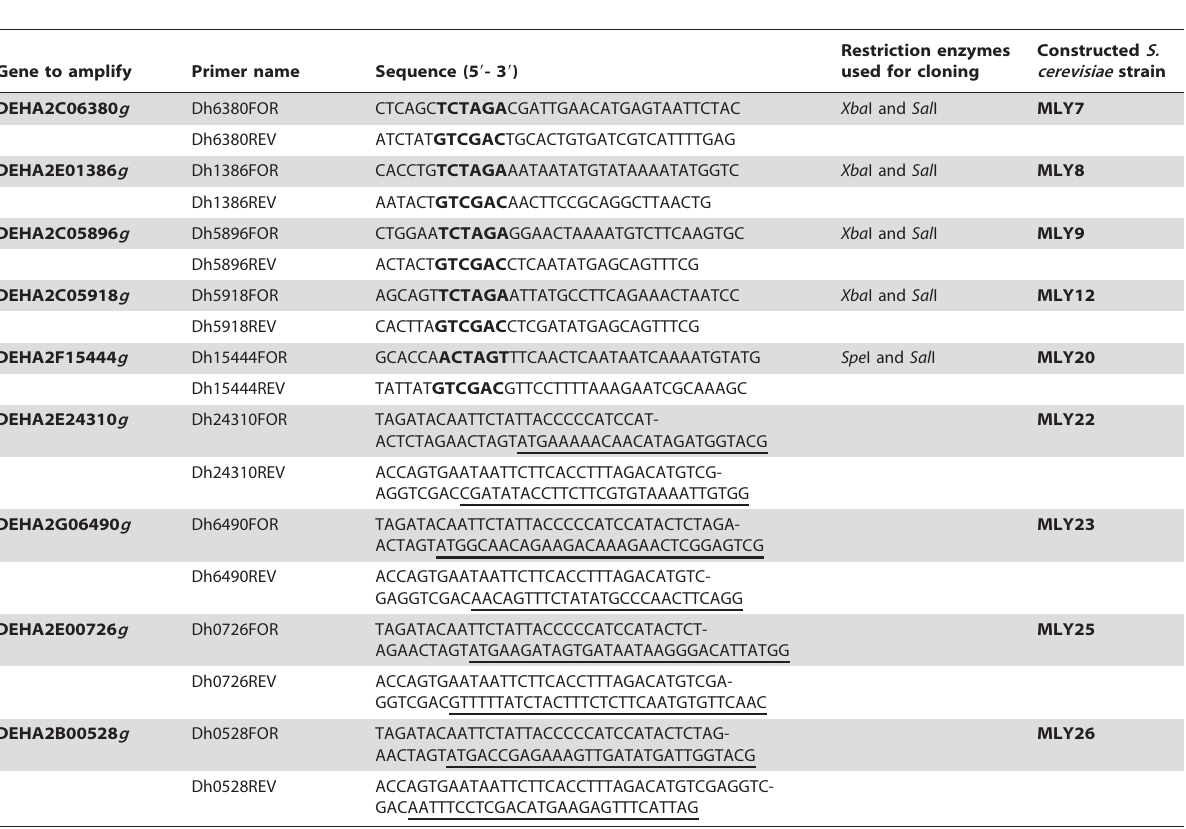
Table 3. Primers used in this work (restriction sites in primers used to clone by restriction digestion and ligation are in bold; sequences homologous to the D. hansenii genes cloned by homologous recombination are underlined).